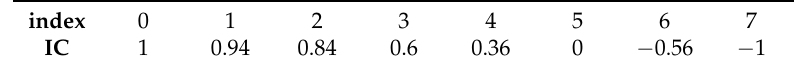
Table 6. Codebook for IC. (IC, Interaural